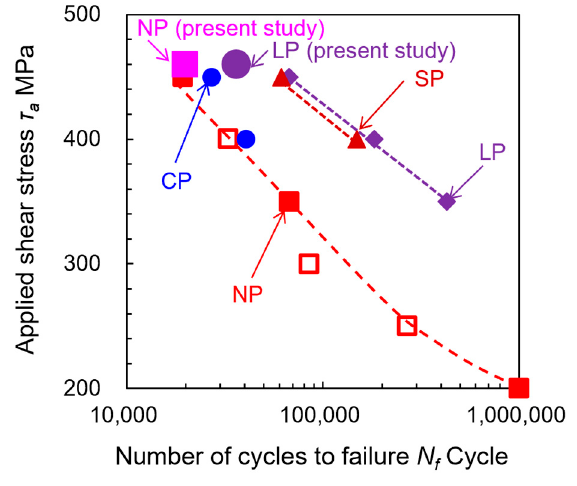
Figure 14. Comparison of fatigue life at τ a = 460 MPa under previous test conditions [27].